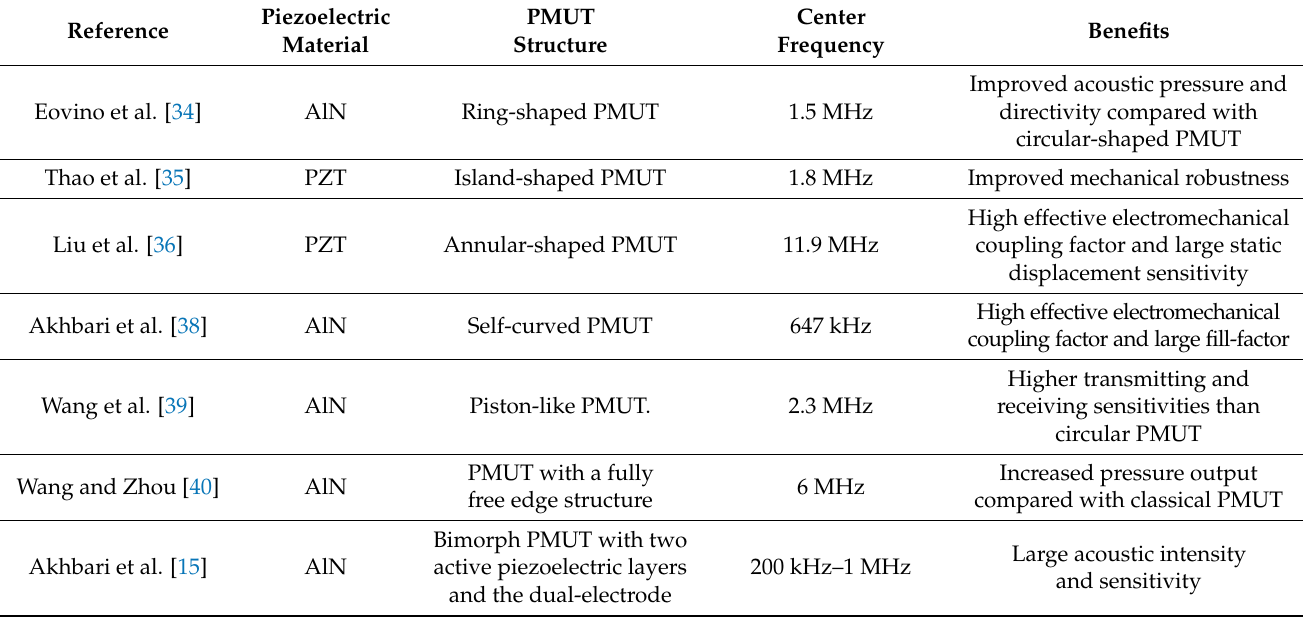
Table 1. Interested readers can refer to the corresponding references for details. Table 1. A summary of PMUT structures reported by